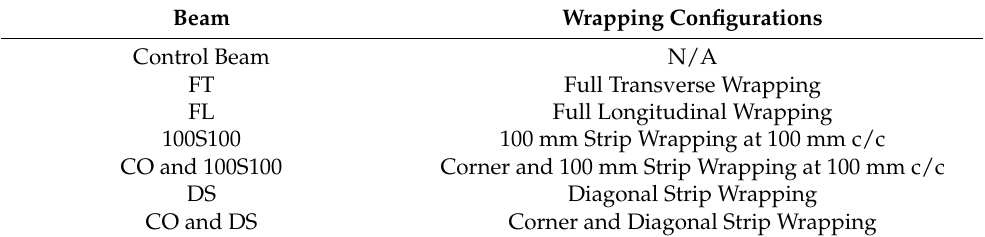
Table 1. Diverse wrapping configurations used for retrofitting.